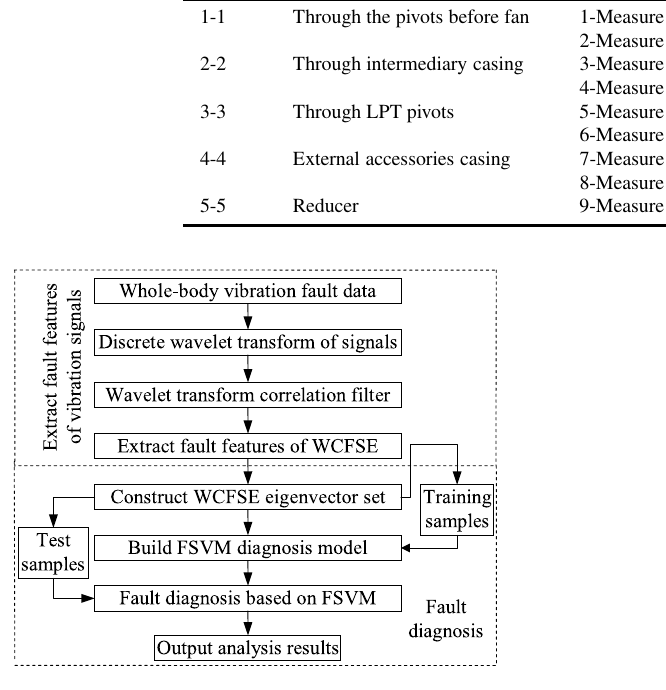
Fig. 1. Aeroengine whole-body vibration fault diagnosis model based on WCFSE-FSVM.